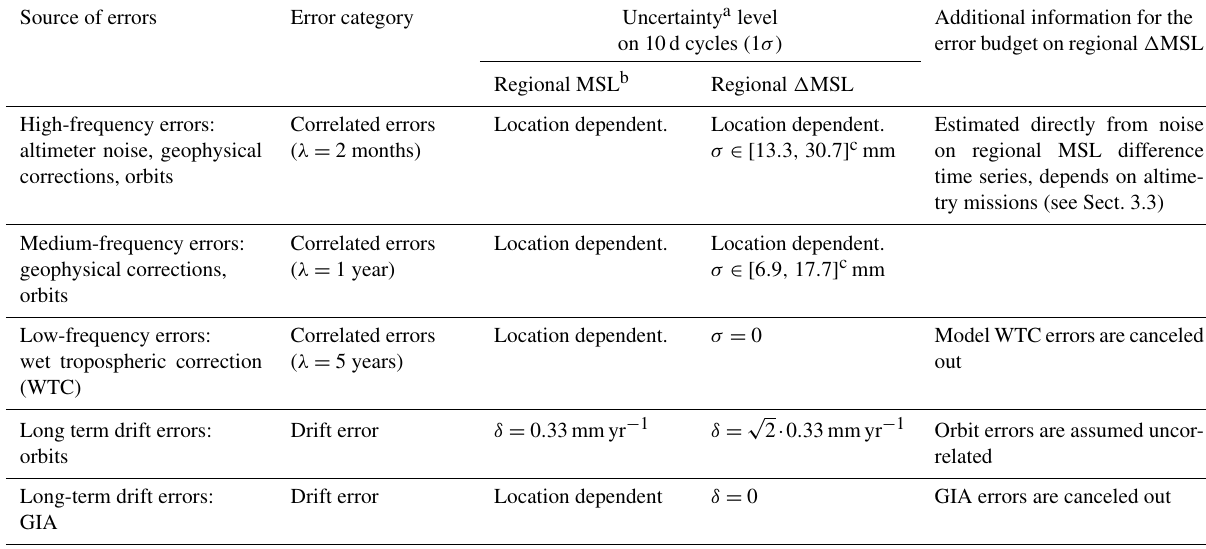
Table 2. Error budget on MSL differences at regional scale between two altimeter missions ( (cid:49) MSL) derived from the MSL error budget at regional scale from Prandi et al.